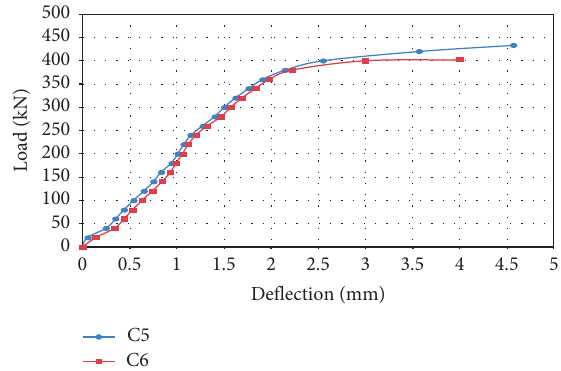
Figure 7: Load-deflection relationship of corbels with 50% and 100% weight fractions of replacement aggregate for concrete strength 45.8 and 44.3MPa and a/d ratio 0.5.